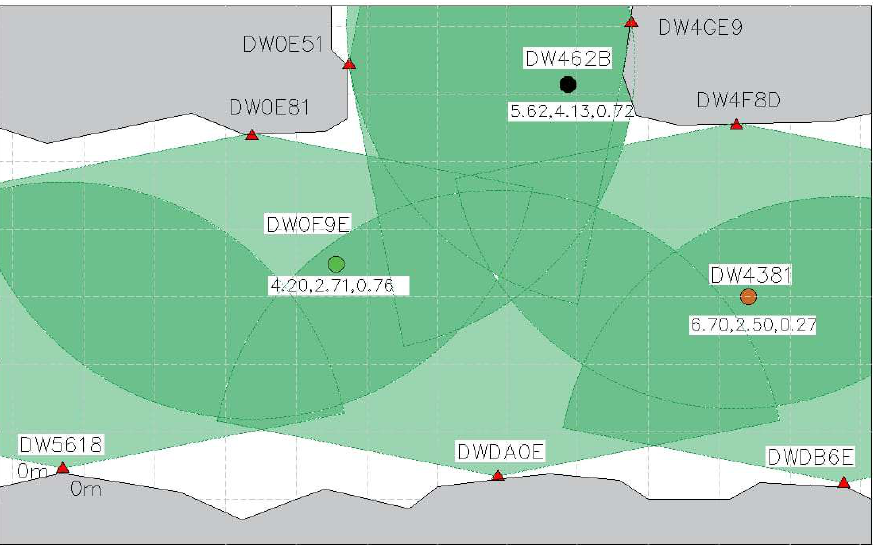
Figure 4. Sketch of a possible sensor layout to mitigate shielding. The light green areas are recog- nized by a single sensor, and the dark green areas are covered by several sensors whose effective radius are overlapping.